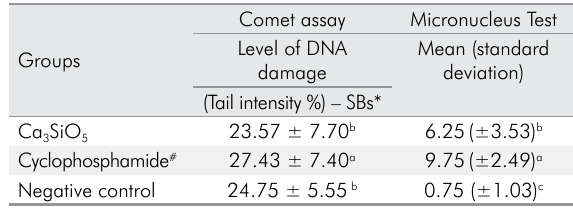
*SBs: strand breaks. # Cyclophosphamide: positive control. Results with different letters differ significantly (p